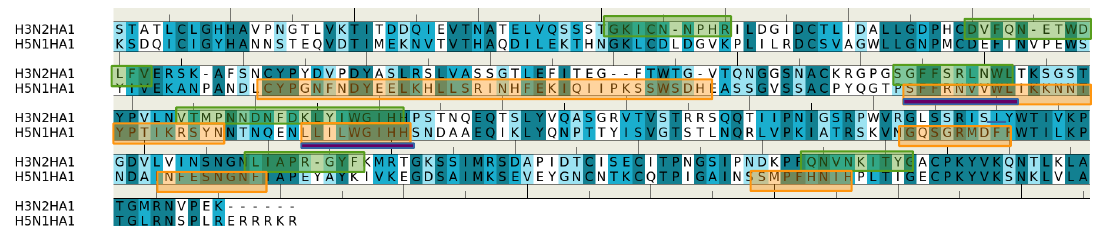
Figure 12. ( A ) the predicted epitopes of H5N1 HA1 ( A ) to antibody 4F5. The epitopes are highlighted in lower case and colored orange in the protein sequence. ( B ) Backbone representation of the antigen H5N1 HA1 showing the predicted epitopes in orange and the antibody in surface. ( C ) Sequence alignment of HA1 protein of influenza viruses H3N2 and H5N1. The boxes highlight the epitopes predicted for H3N2 (green) and H5N1 (orange). The overlay regions between two subtypes are underlined in purple. Figures were prepared using PyMOL